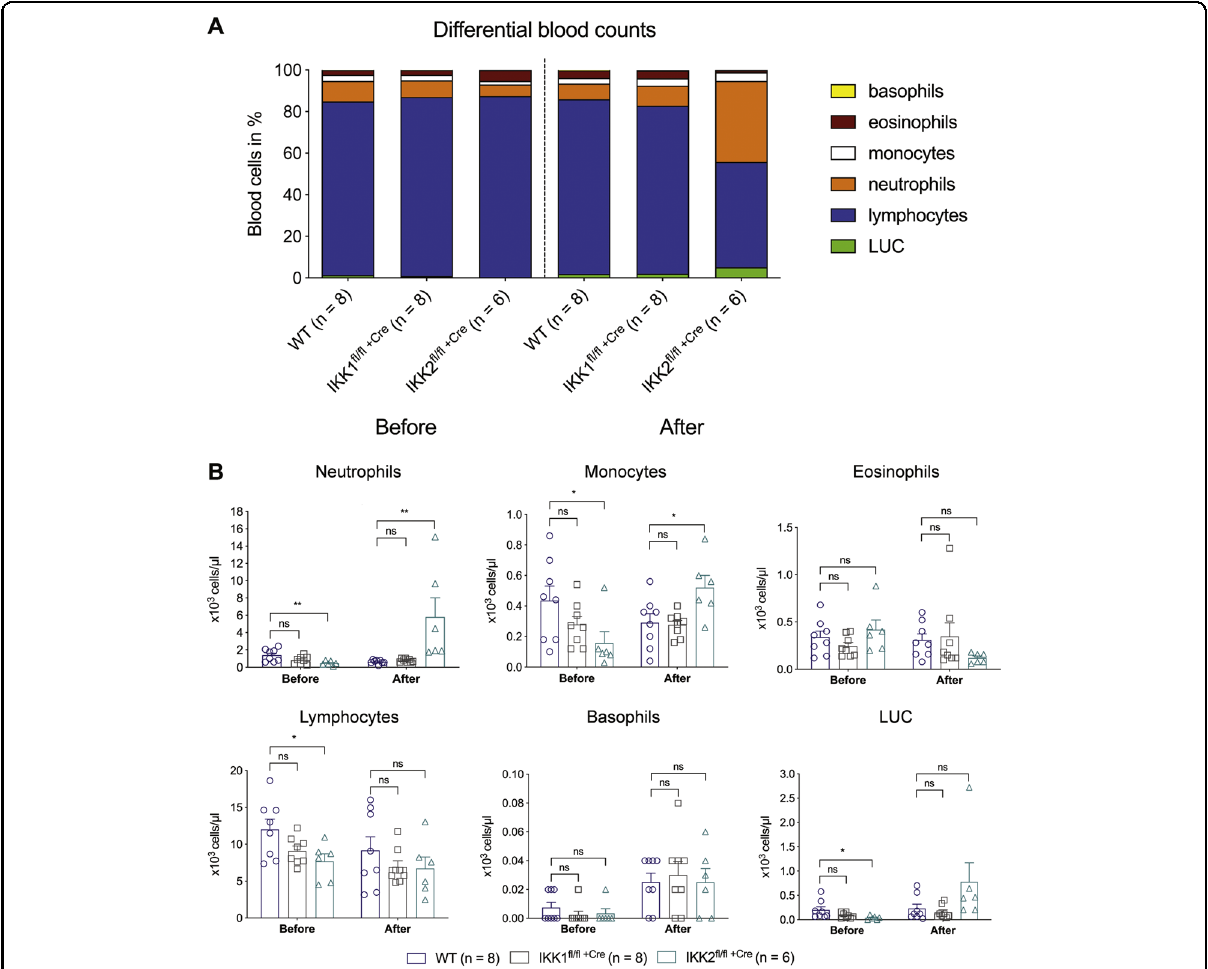
Fig. 3 Loss of IKK2 in haematopoietic stem cells results in neutrophilia, monocytosis and eosinopenia in peripheral blood. Analysis of peripheral blood pro fi le in control and IKK- fl oxed mice before and after gene deletion in haematopoietic cells at the time of sacri fi ce. A Differential white blood cell counts, B total white blood cell counts. Neutrophil, monocyte, eosinophil, lymphocyte, basophil and large peroxidase-negative cell (LUC) count as assessed on the Avida 2120 haematological analyser. Data are presented as means ( A ) and means + SEM ( B ) from 6 to 8 mice of each genotype of two independent experiments. Graphs are representative of a typical experiment. ns p > 0.05; * p ≤ 0.05 and ** p ≤ 0.01 as determined by one-way ANOVA (WT Cre + after tamoxifen treatment vs. IKK2 fl / fl Cre + after tamoxifen treatment: neutrophils p = 0.0048; monocytes p = 0.0141; eosinophils p = 0.2922; lymphocytes p = 0.4282; basophils p = 0.8841; LUC p = 0.0896) and Dunnett ’ s multiple comparison